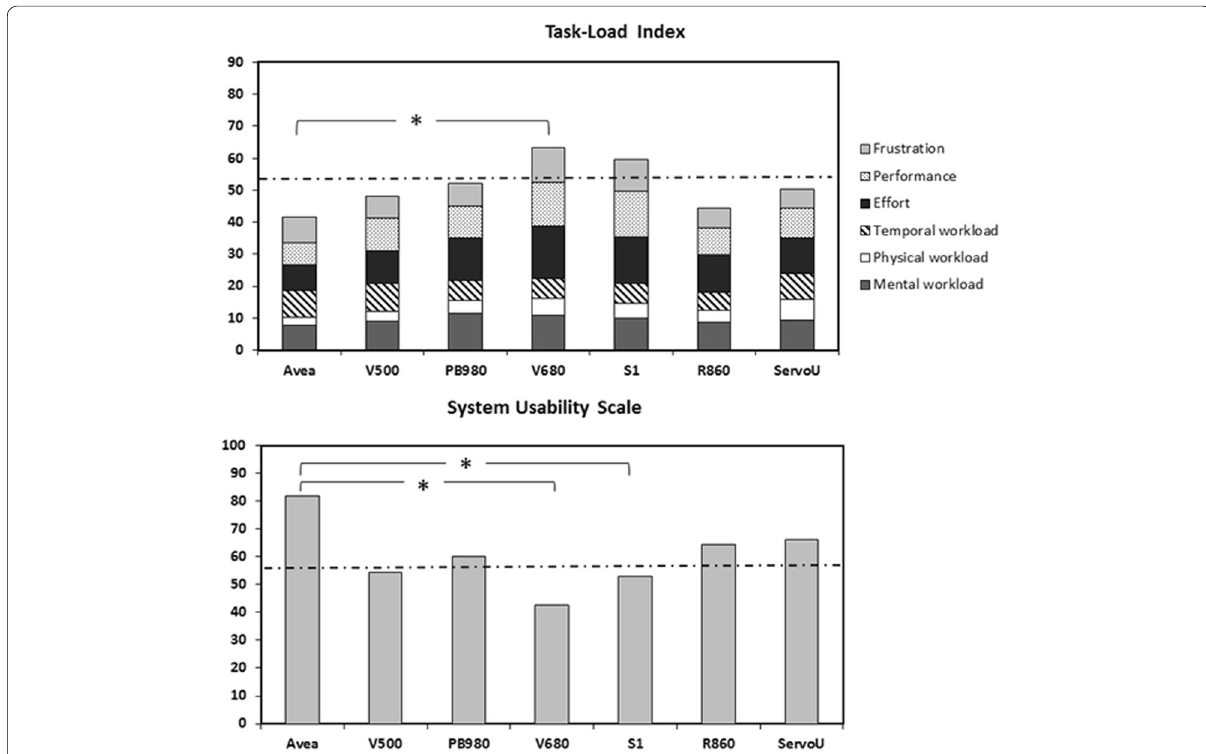
Fig. 5 Task Load Index and System Usability Scale scores. Dotted line represents the mean value across all scores (Avea excluded). SUS consists of a ten-item questionnaire and assesses usability from different aspects: effectiveness (ability of users to complete tasks); efficiency (level of resource used in performing tasks); and satisfaction (subjective reactions to using the system). SUS score has a range of 0–100, the highest score being the best value (‘simple to use’). NASA-TLX is a multidimensional tool developed for mental workload evaluation. It explores three dimensions dependent on user perception of the task (mental workload, temporal workload and physical workload) and three dimensions dependent on the interaction between the subject and the task itself, which may be mostly related to the interface (effort, performance and frustration). An individual weighting of these dimensions by letting the subjects compare them pairwise enables a decrease in the inter-/intra-individual variability of the overall score. The higher the TLX, the lower the ergonomics. Our reference device (Avea) had the best TLX and SUS scores, and V680 the worst ( p 0.049). For usability (SUS), a difference between our reference device (Avea) and S1 was also observed. * p value =